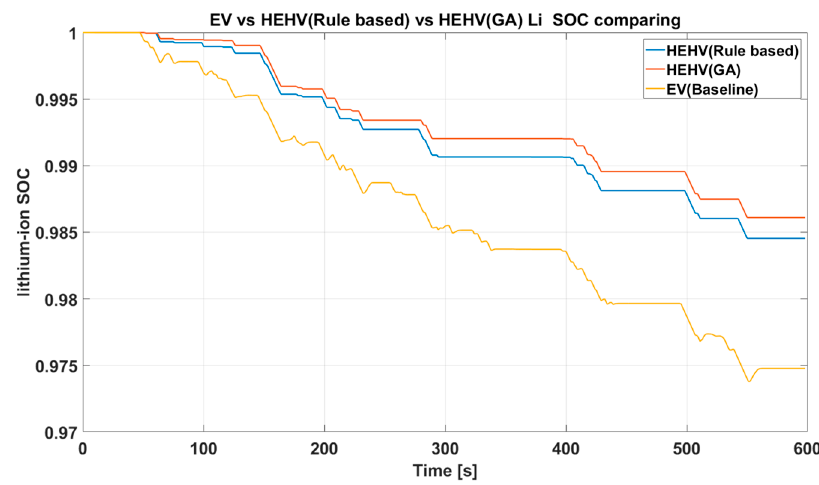
Figure 18. Battery SOC comparison between HEHV (Rule based), HEHV (GA), and EV. Table 4. Comparison between electricity economic performances.